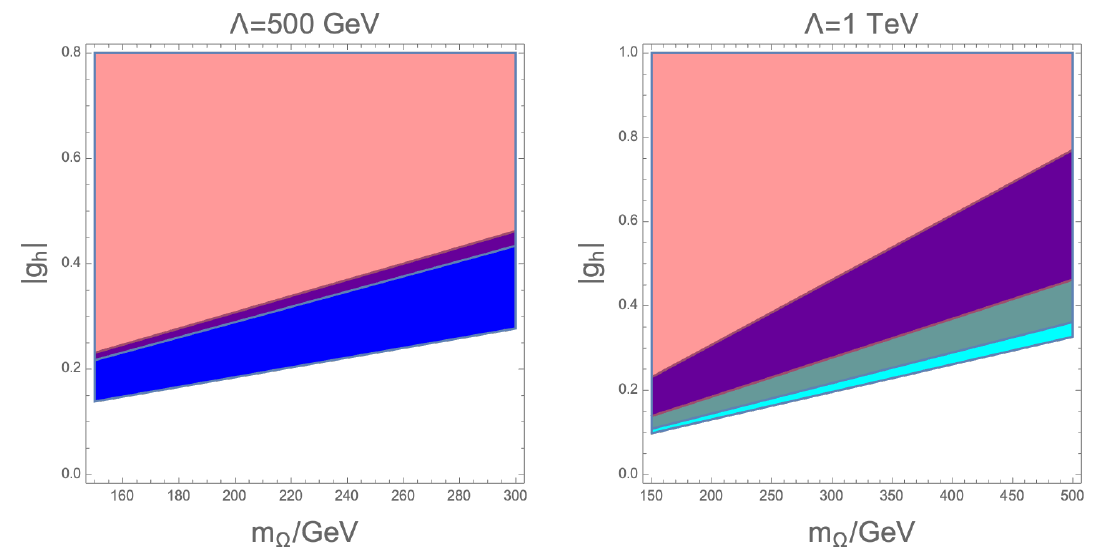
Figure 3 . Parameter spaces on the m Ω - g h plane for the UV cutoff to be Λ = 500 GeV (left panel) and 1 TeV (right panel), respectively. In each plot, the blue region represents the parameter space which can explain the muon g − 2 at 2 σ CL, while the red region is excluded by the perturbative unitarity bound. The cyan region on the right panel can account for at least 50% of the muon g − 2